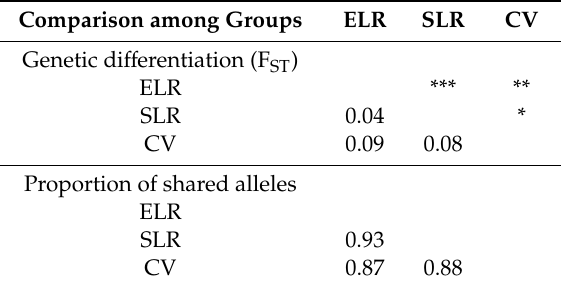
Table 3. F ST values (below diagonal) and relative significance of the test (above diagonal) and proportion of shared alleles between pairs of sub-populations based on the 2470 SNPs.